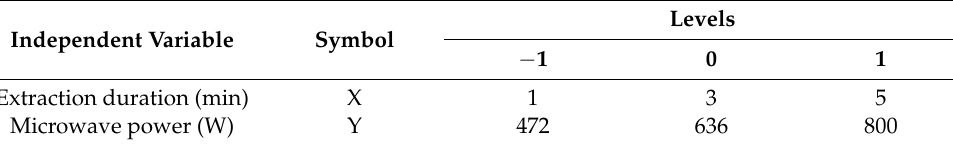
Table 1. Extraction variables and their levels.